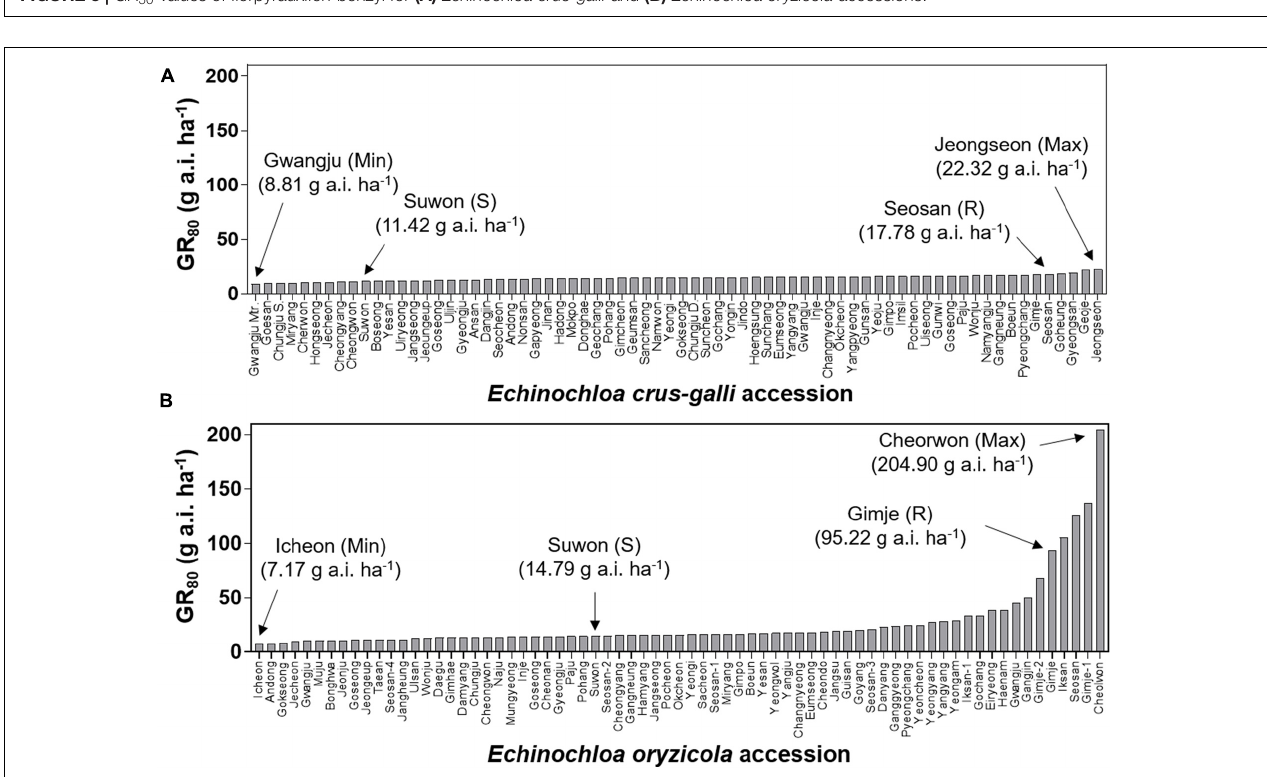
FIGURE 4 | GR 80 values of florpyrauxifen-benzyl for (A) Echinochloa crus-galli and (B) Echinochloa oryzicola accessions.